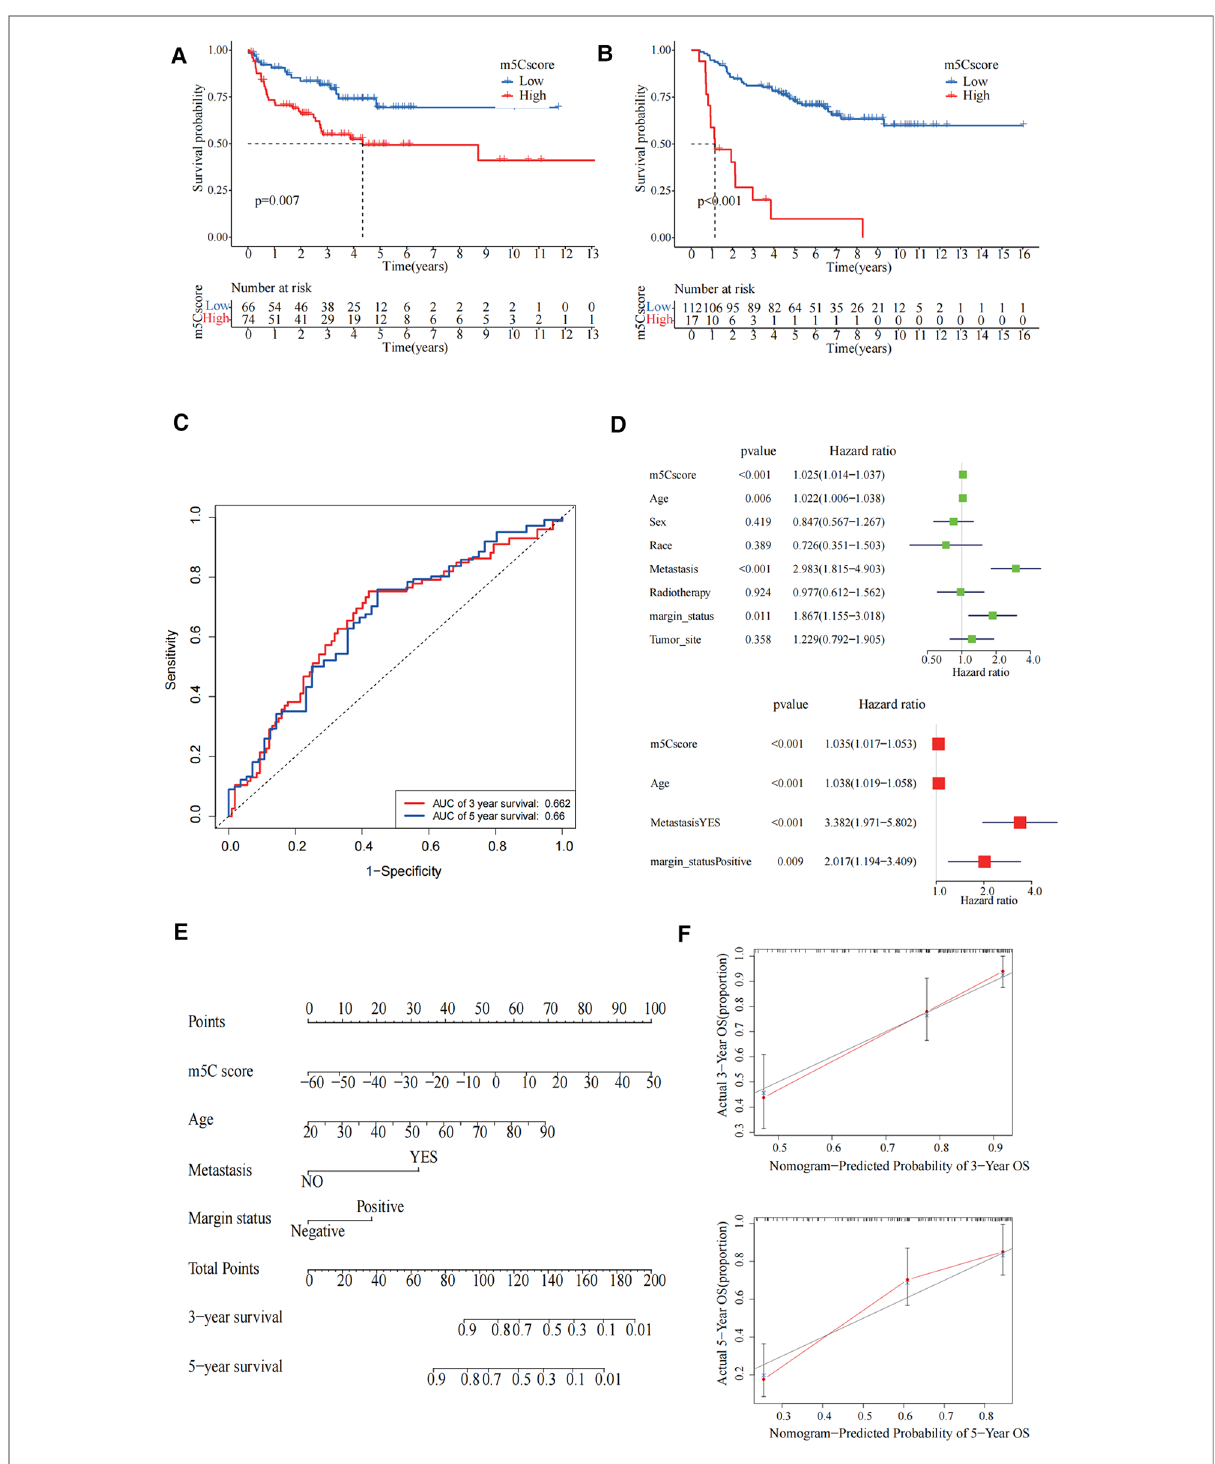
FIGURE 6 Validation of 5-methylcytosine (m5C) modi fi cation patterns and clinical application. ( A ) The survival curve showed high m5C score group had worse prognosis in GSE30926 cohort ( p =0.007). ( B ) The survival curve showed that the high m5C score group had a worse prognosis in the GSE17674 and GES63157 cohorts ( p <0.001). ( C ) The predictive value of the m5C score in The Cancer Genome Atlas (TCGA)-sarcoma cohorts. Three-year area under the curve (AUC)=0.662, 5-year AUC=0.66. ( D ) Univariate and multivariate Cox regression analysis for m5C score in TCGA cohort shown by the forest plot. ( E ) Nomogram for predicting patient survival at 3-year and 5-year. ( F ) Calibration curve showed the prediction power of nomogram in 3 years and 5